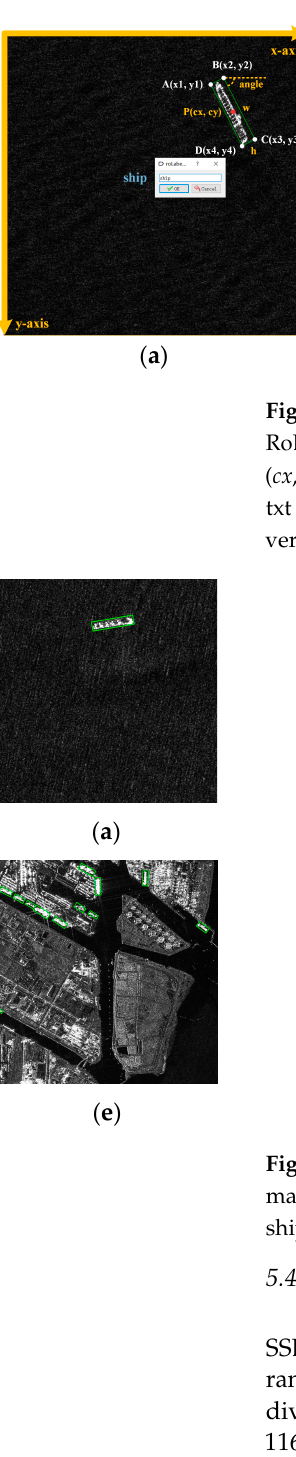
Figure 14. AIS query and Google Earth correction (take No.1 Sentinel-1 image as an example). ( a ) AIS information of the coverage. Marks of different shapes and colors represent different types of ships; ( b ) corresponding Google Earth image.